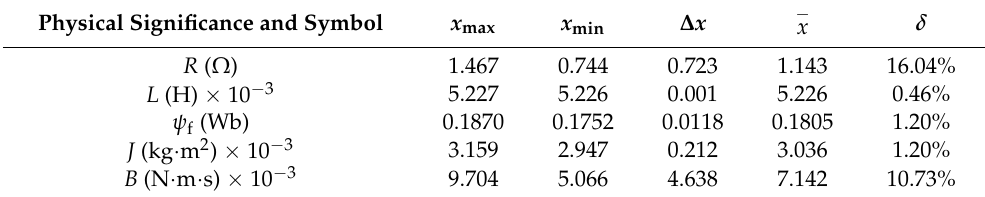
Table 3. Multiparameter identification of a PMSM result based on the PSO algorithm.